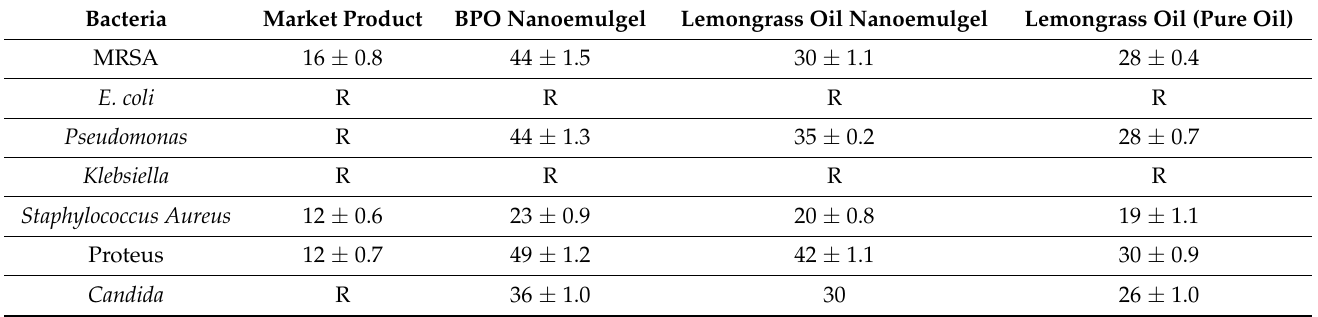
Table 2. The antibacterial activity of lemongrass oil, lemongrass nanoemulgel and Benzoyl peroxide nanoemulgel compared with the market